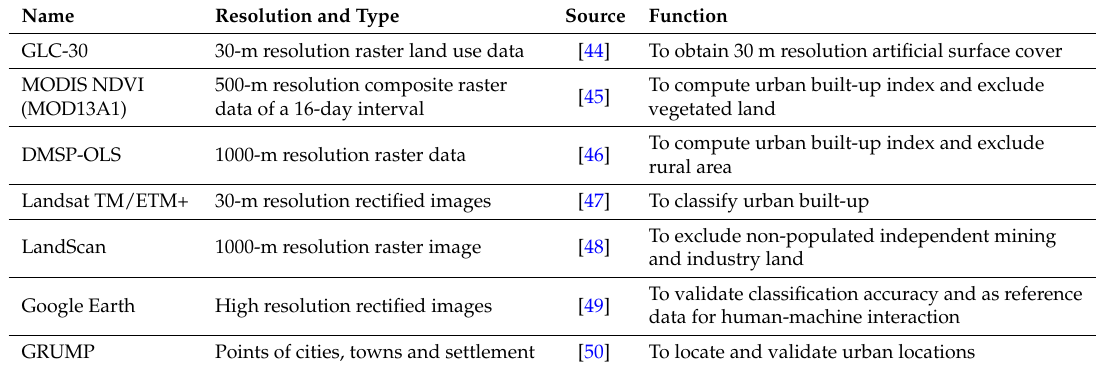
Table 1. The spatial resolution, data type, data source and main function of the data used for mapping the urban built-up